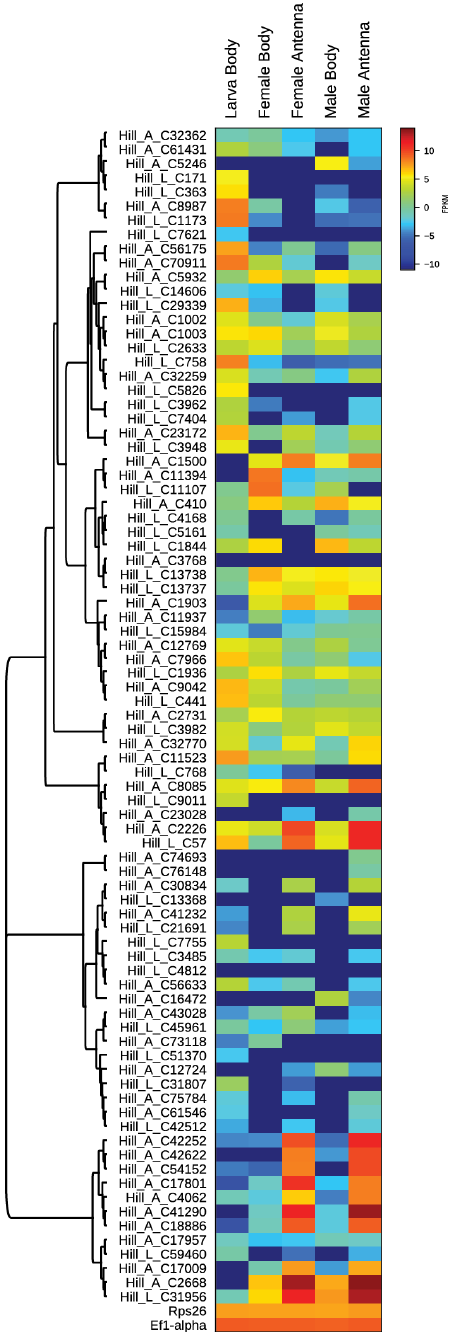
Figure 1. Heat map showing differences in the expression of OBPs between BSF adult male and female individuals (antennae and whole bodies) and in BSF larvae. The map is based on log2- transformed FPKM values shown in the gradient heat map (blue represents low-expressed genes and red represents high-expressed genes). The housekeeping genes 40 S ribosomal protein 26 (Rps26) and elongation factor 1-alpha (EF1-alpha) are used for normalization and are shown to confirm the uniform expression of these control genes across samples.